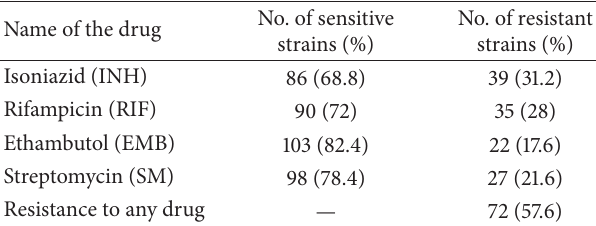
Table 1: Sensitivity pattern of MTB to four antitubercular (ATT) drugs.